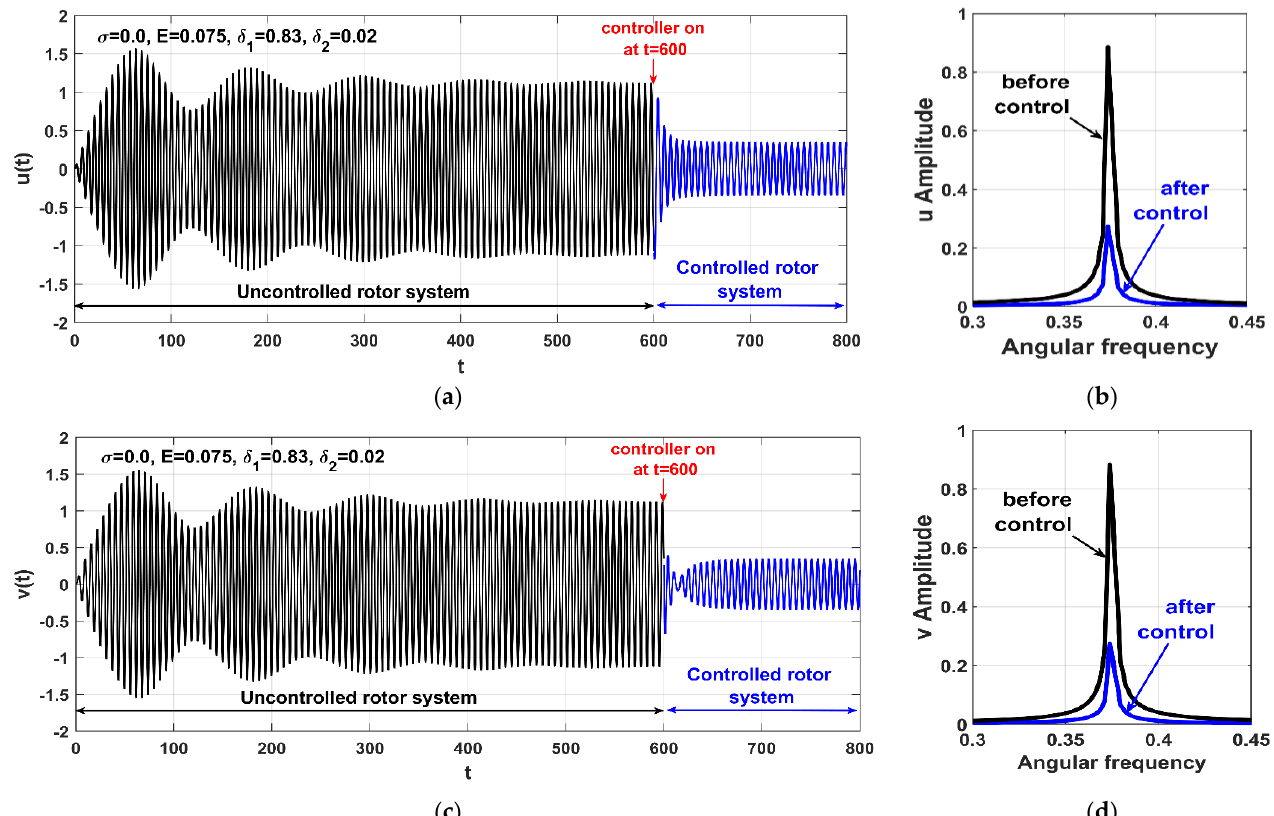
Figure 23. Time-response and the corresponding frequency-spectrum of the Jeffcott-rotor system before and after control according to Figure 22 at σ = 0.0, E = 0.075, λ = 0.05, δ 1 = 0.83, δ 2 = 0.02 when turning the controller on at time t = 600: ( a , b ) the normalized temporal oscillations u ( t ) and the corresponding frequency spectrum in X direction, ( c , d ) the normalized temporal oscillations v ( t ) and the corresponding frequency spectrum in 𝑌 direction.